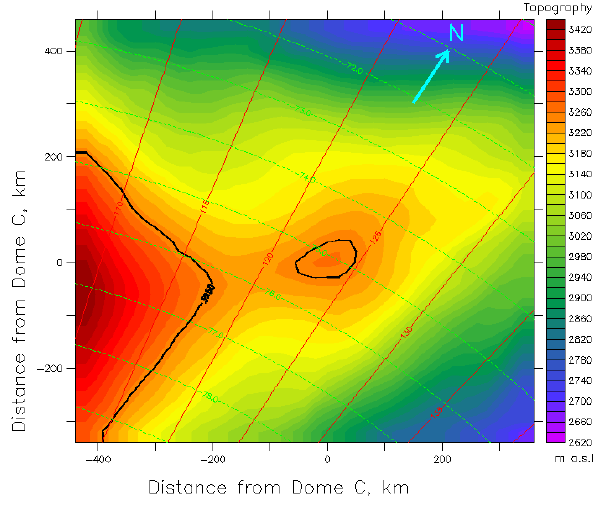
Figure 1. The MAR integration domain and topography. The solid line refers to the 3250m